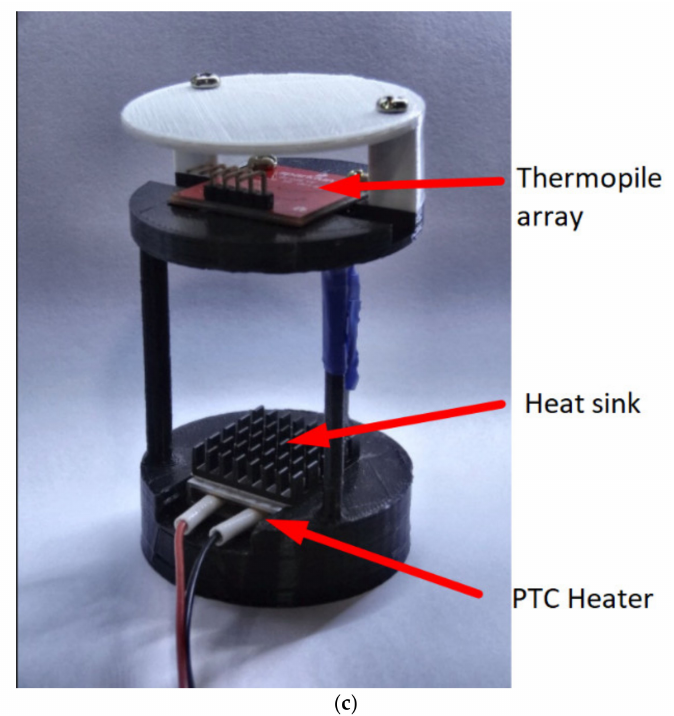
Figure 1. Diagram of proposed sensing device. ( a ) Diagram showing the working principle, ( b ) completely assembled system, ( c ) picture of proposed system assembled on a 3D printed